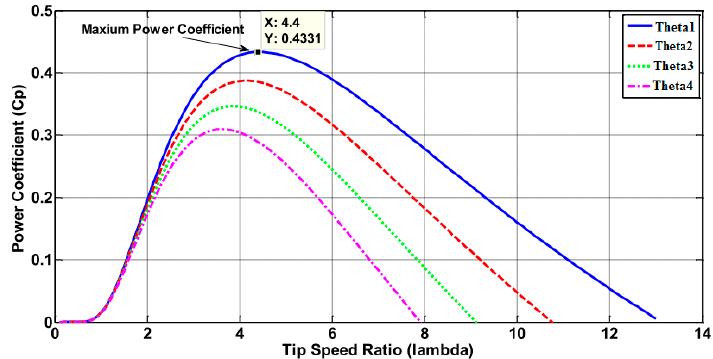
Figure 3. The power coefficient curves with different pre-setting pitch angle.